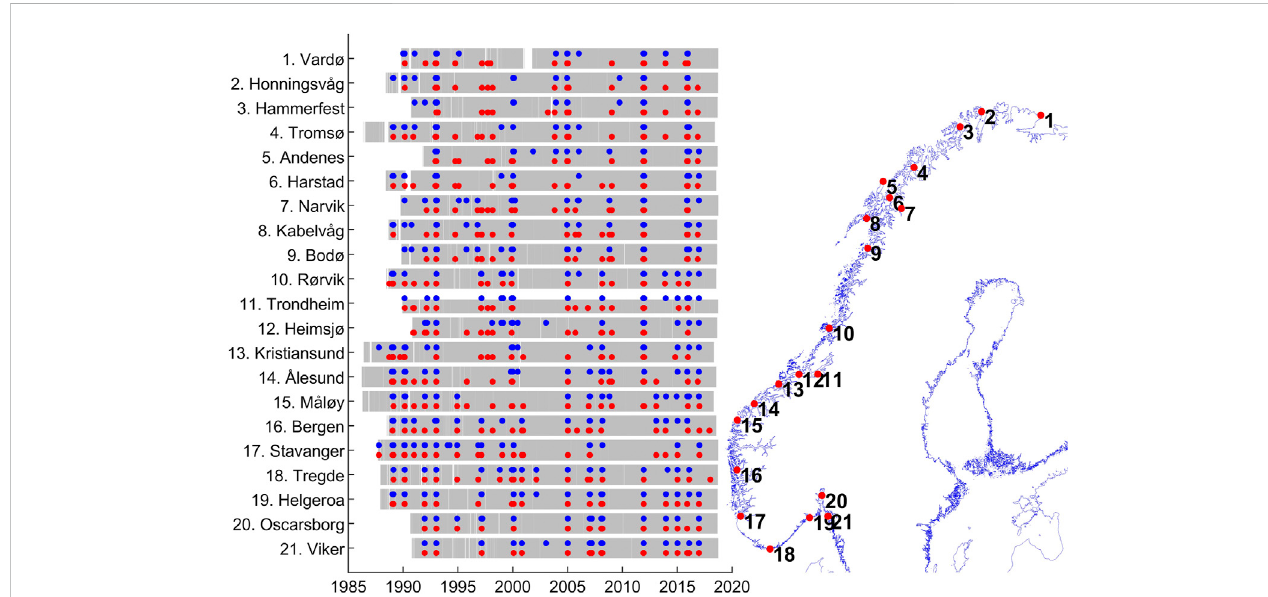
FIGURE 1 Overview over the 21 permanent tide gauges. Left: Data availability for each TG in grey. Cases of extreme sea level and extreme skew surge are marked with red and blue dots, respectively. Right: Location of the TGs along the Norwegian coastline (from EEA,